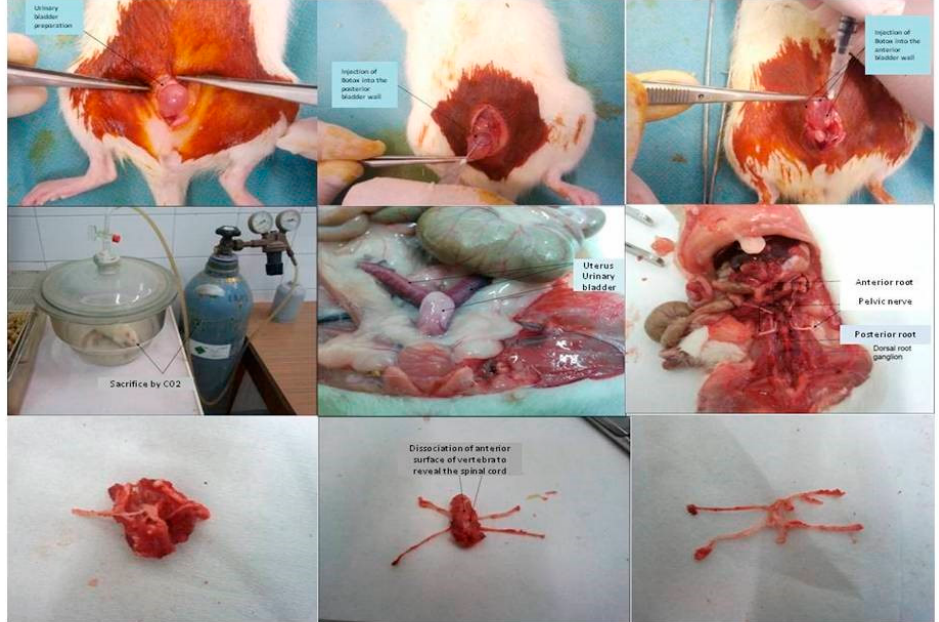
Figure 7. Representative photos from various stages of the feasibility experiment. Upper panel: Left—surgical preparation of the urinary bladder in anaesthetized rat. Middle—injection of OnabotulinumtoxinA into the posterior bladder wall. Right—injection of OnabotulinumtoxinA into the anterior bladder wall. Middle panel: Left—sacrifice of experimental animal by CO 2 . Middle—surgical preparation of the urinary bladder. Right—surgical preparation of the lumbosacral spinal region with identification of the pelvic nerve, the posterior and anterior L6-S1 roots, and the respective dorsal root ganglion Lower panel: Left—isolated preparation of the L6-S1 spinal region. Middle—removal of the anterior spinal surface to reveal the spinal cord. Right—final preparation of the L6-S1 spinal cord, L6-S1 roots, and dorsal root ganglia